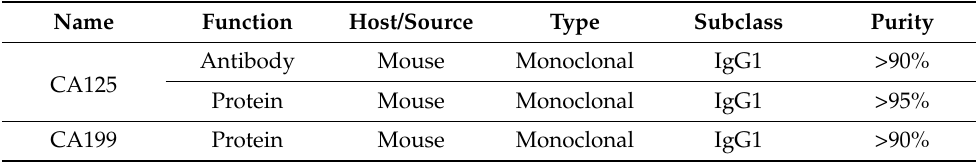
Table 1. Material information of detection